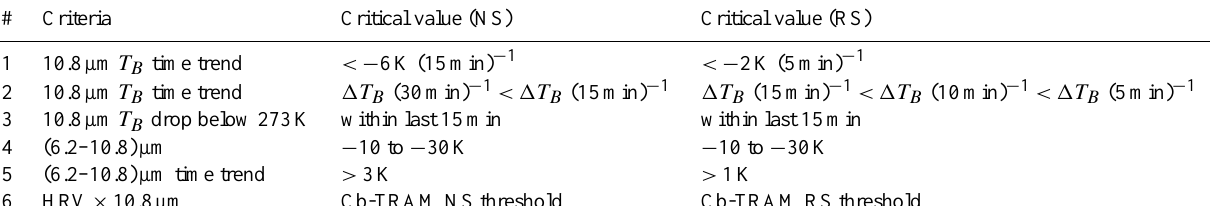
Table 3. Set of six criteria used for the new CI detection algorithm together with the individual thresholds for NS and RS.